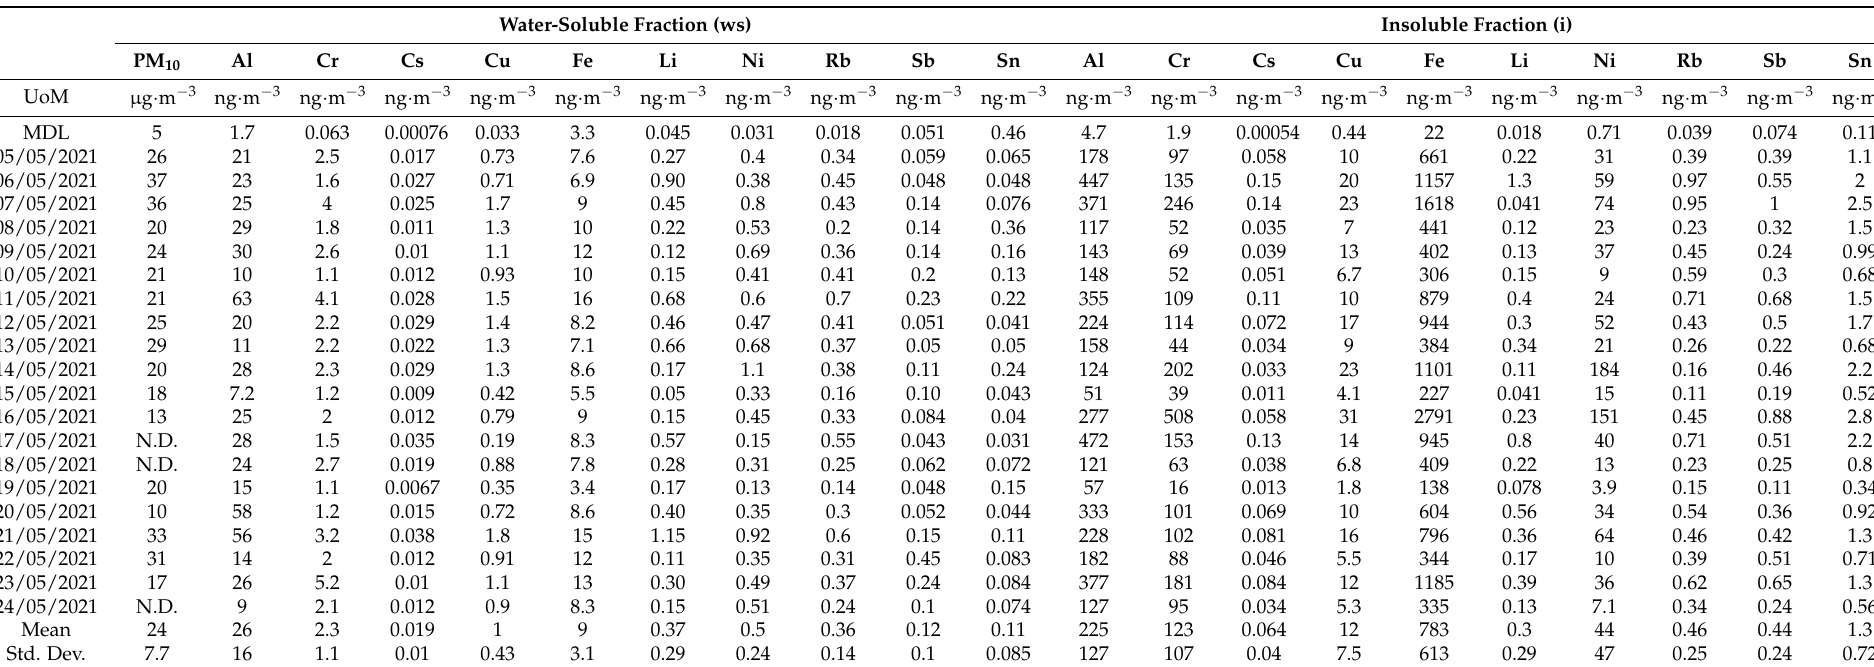
Table 1. Minimum detection limit (MDL), concentrations, mean and standard deviation of PM 10 mass, and of the elements analyzed in the water-soluble